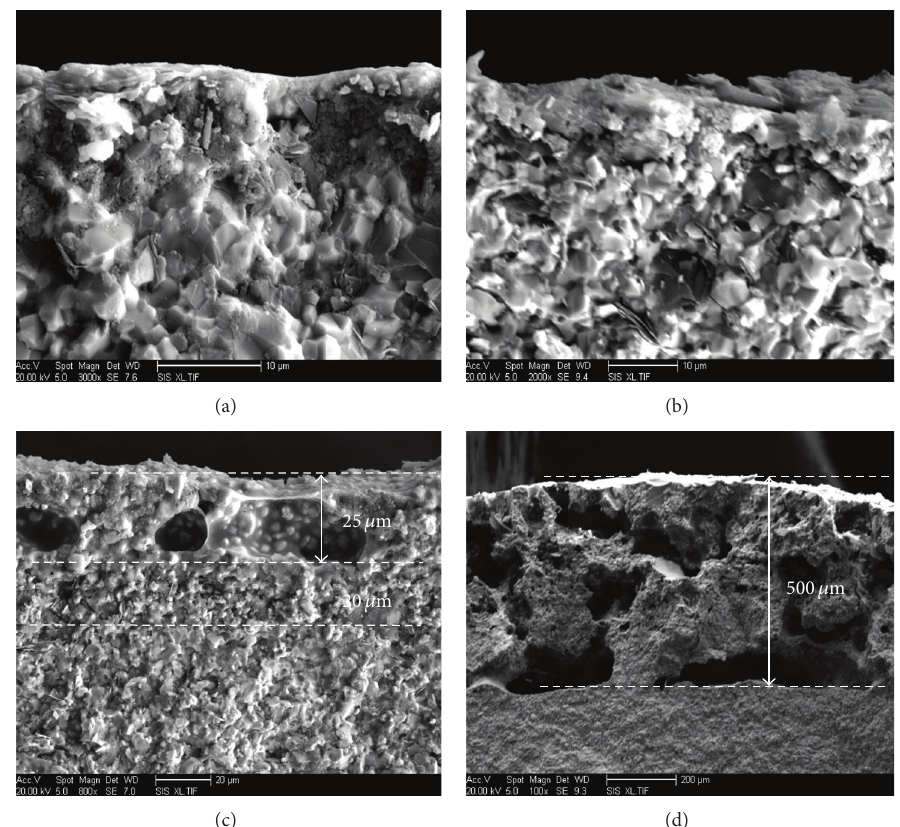
Figure 8: Cross-section micrographs of ZSB materials after thermal shock at different temperature for 30 times: (a) 1200 ∘ C; (b) 1400 ∘ C; (c) 1600 ∘ C; (d) 1800 ∘